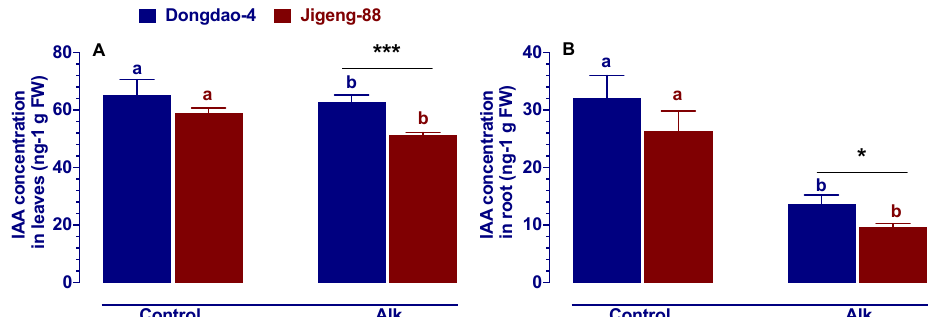
Figure 1. IAA concentrations of ( A ) shoots and ( B ) roots of Dongdao-4 and Jigeng-88 seedlings grown in control and alkaline stress medium. Two-week-old rice seedlings cultivated in normal culture solution were moved to culture solution that was added with 20 mM NaHCO 3 and had a pH of 8.5 for 5 days. Alk = alkaline stress. Bars = 10 cm. Data are means ± SE (n ≥ 5). Means with different letters are significantly different between control and alkaline stress of the same genotype ( p < 0.05). Asterisks indicate significant differences within the same treatment (* p < 0.05, *** p < 0.001).